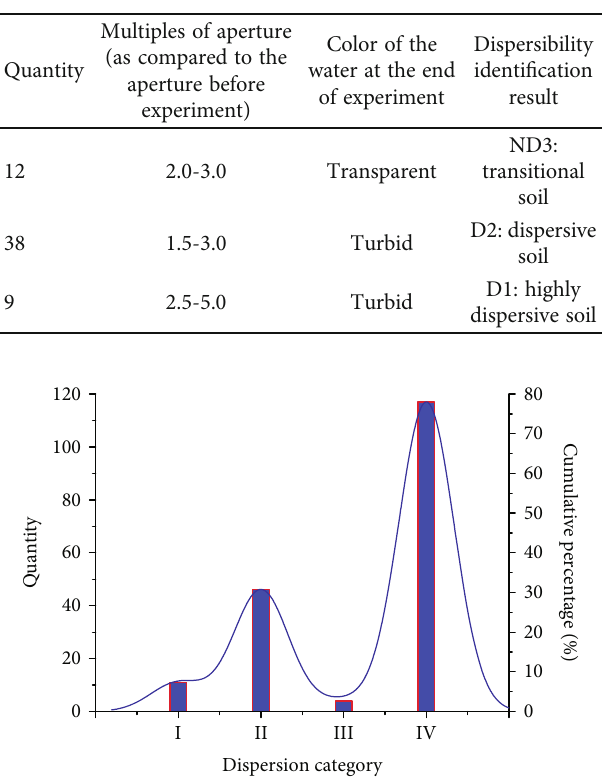
Table 4: Results of the pinhole experiment.